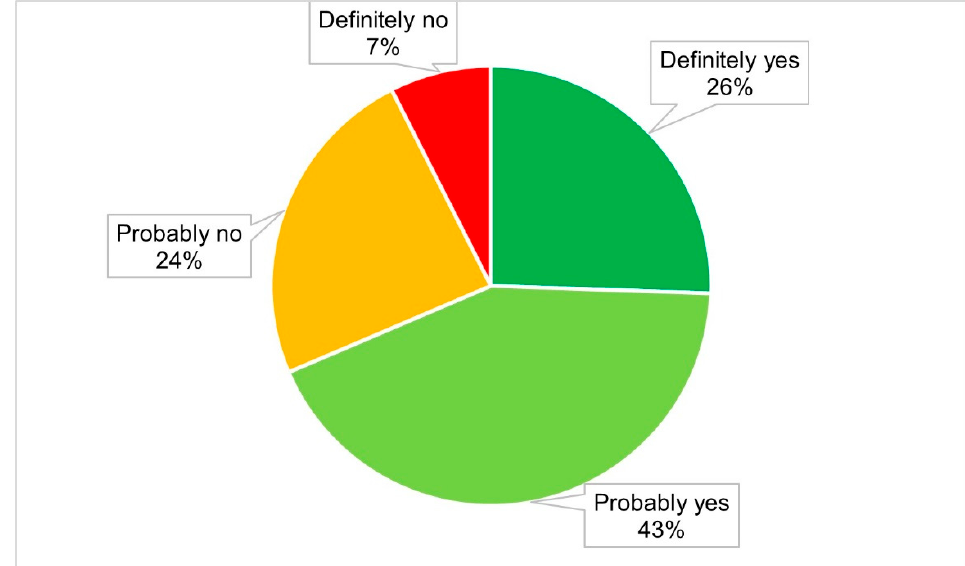
Figure 2. COVID-19 vaccination intent in Bangladesh. Table 2. Sociodemographic predictors of SARS-CoV-2 vaccination intent in Bangladesh, multivariable logistic regression analyses.